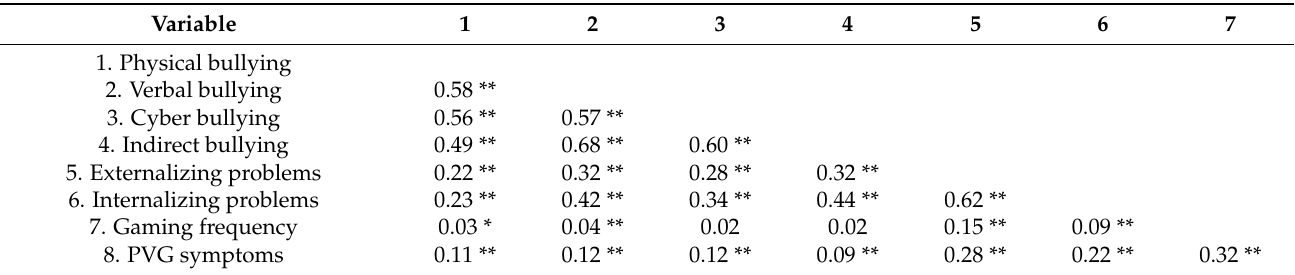
Table 2. Pearson’s correlation coefficients between